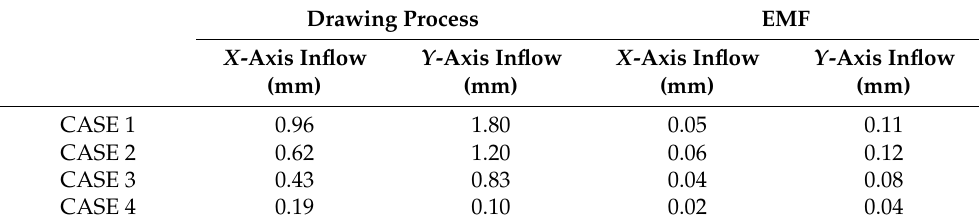
Figure 10. Distance between sheet and die (forming accuracy) for ( a ) CASE 1, ( b ) CASE 2, ( c ) CASE 3, and ( d ) CASE 4. Table 5. Sheet inflow of each after